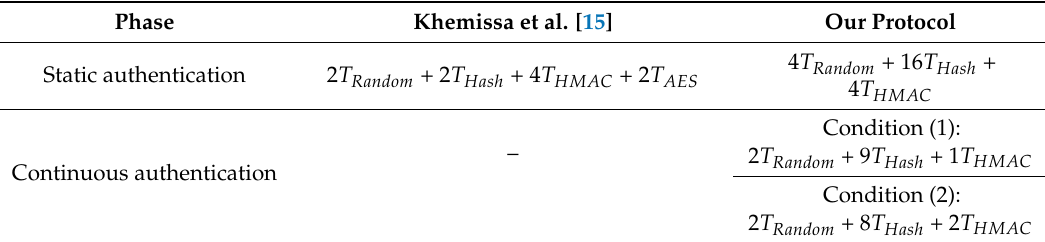
Table 2. The comparison result on computation cost between the protocol of Khemissa et al. and the proposed